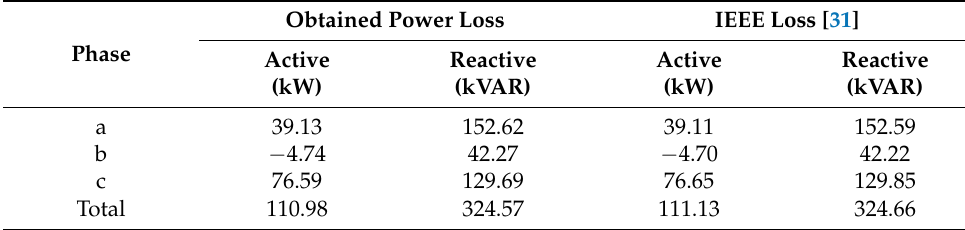
Table 5. Power loss in IEEE − 13 bus URDN.